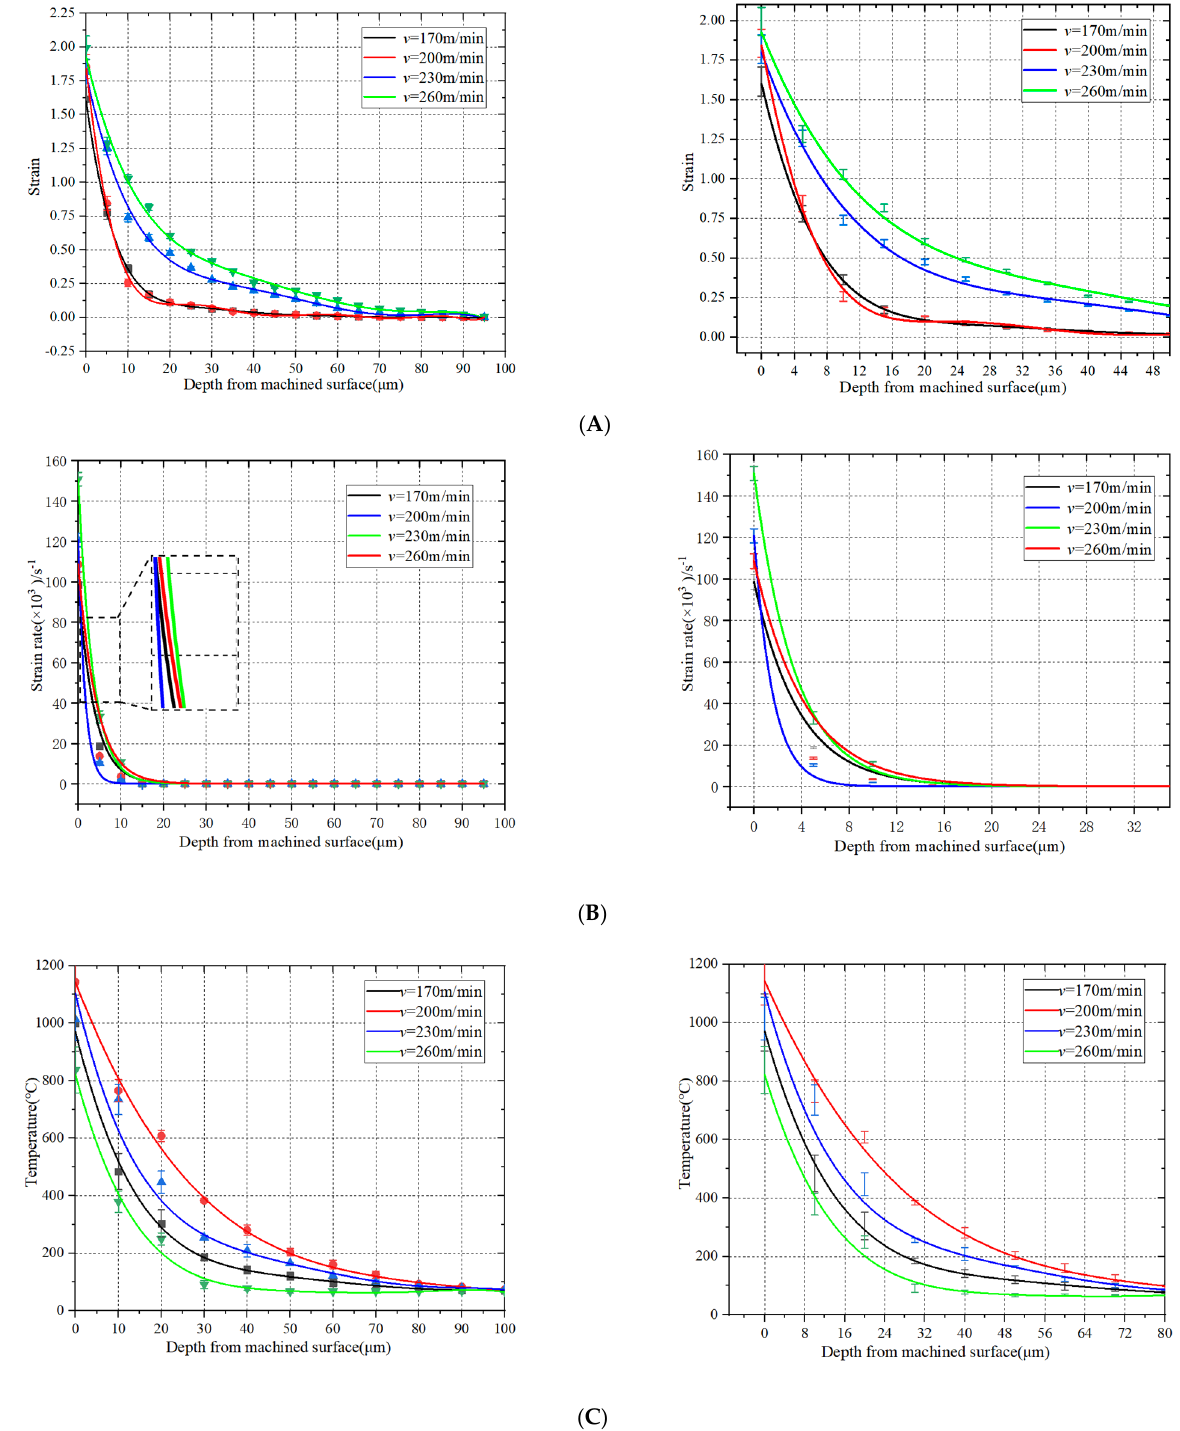
Table 6. Basic parameters of X-ray diffraction test.